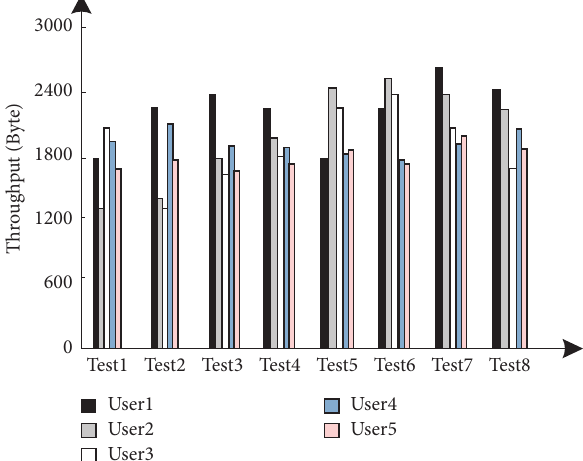
Figure 6: Test effect of platform connection delay response.